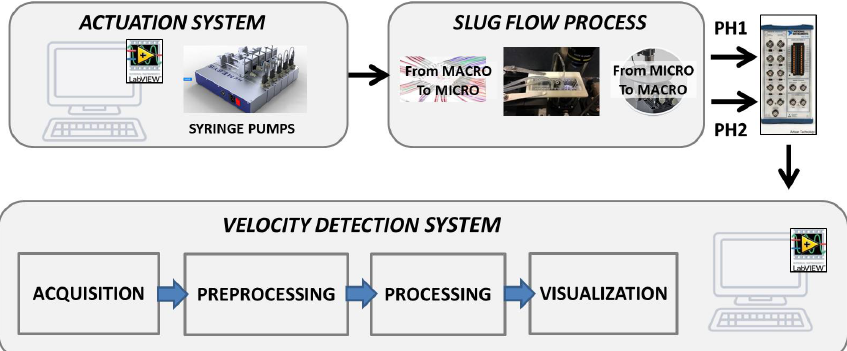
Figure 8. The flowchart of the platform to compute the slug velocity by the analysis of optical signals with the main functional blocks for the data: acquisition, pre-processing, processing, and visualization. The block that manages the pump-computer connection is also pointed out.